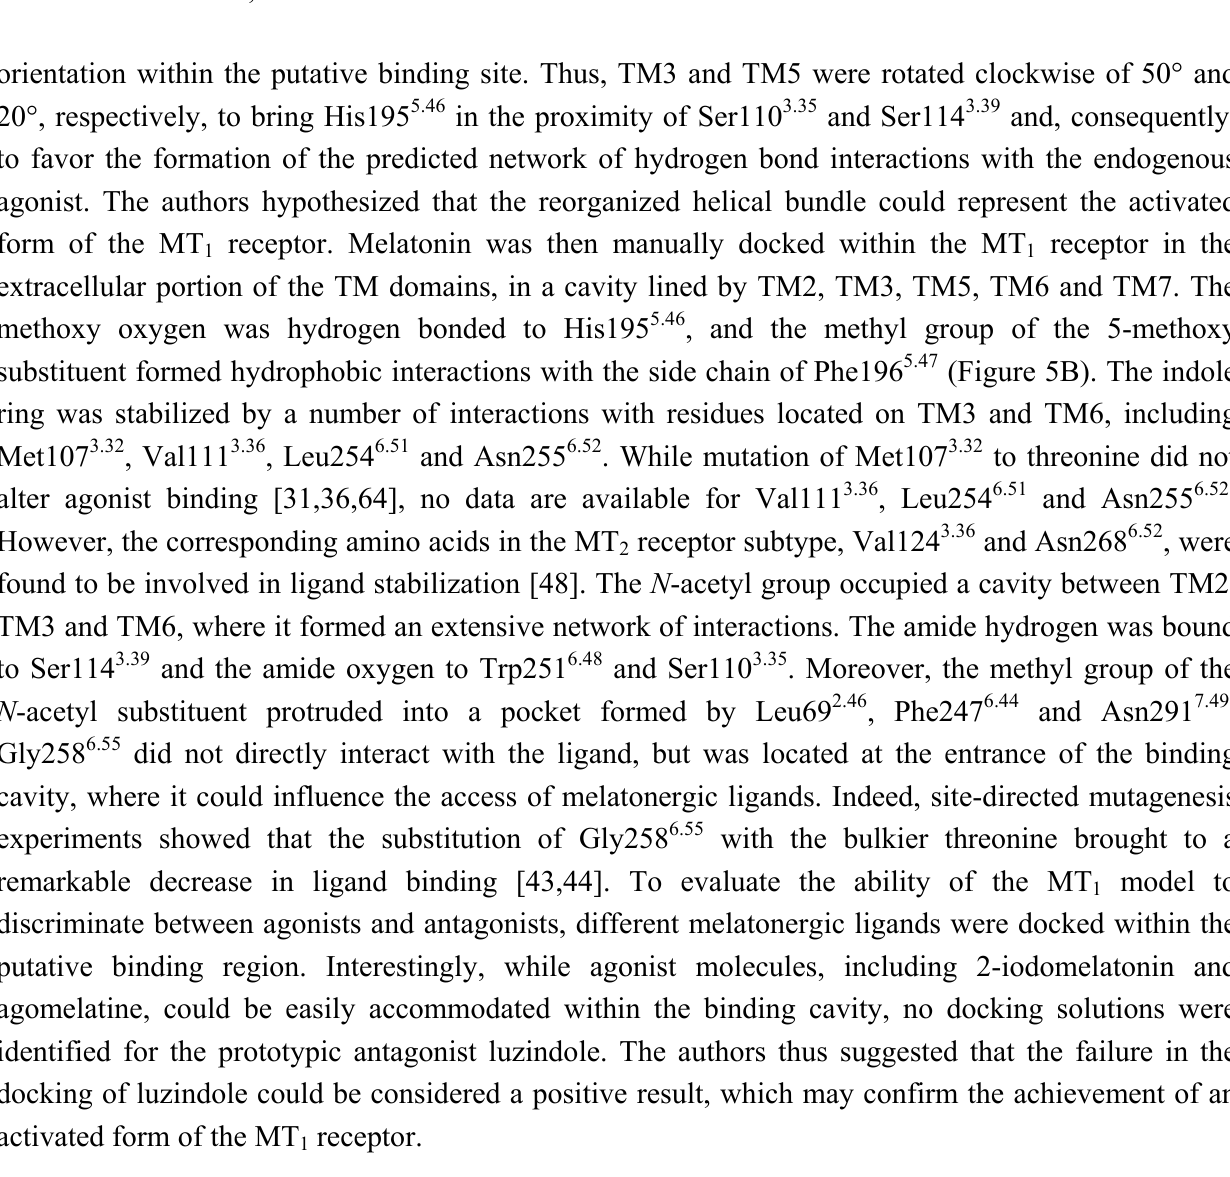
Figure 5. Representation of the melatonin binding scheme proposed by Chugunov et al. ( A ) and by Farce et al. ( B ) within the MT depicted with orange